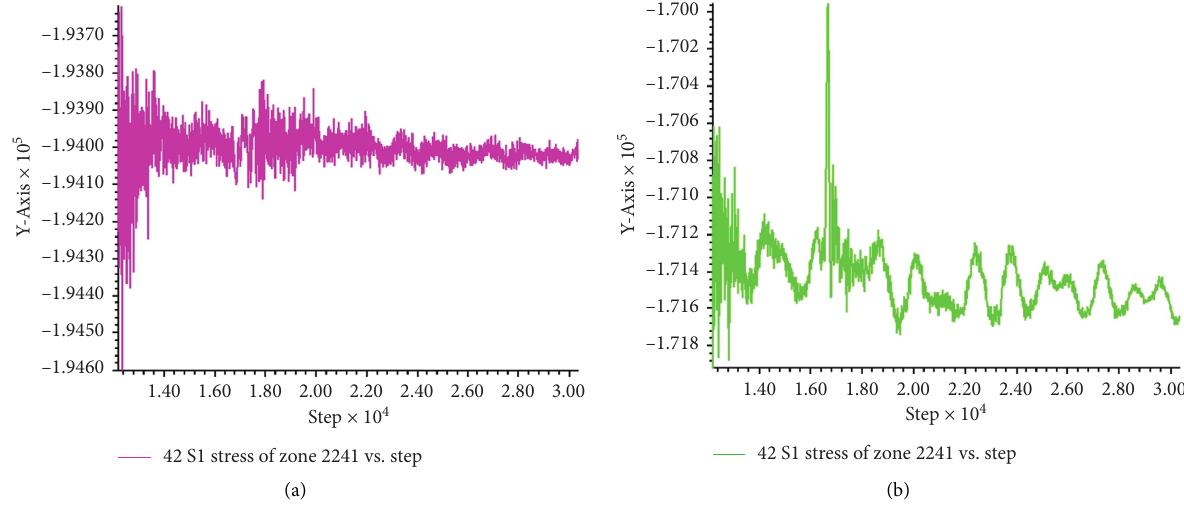
Figure 12: The maximum principal stress changes when the roadway moves vertically for 10m: (a) left side and (b) right side.